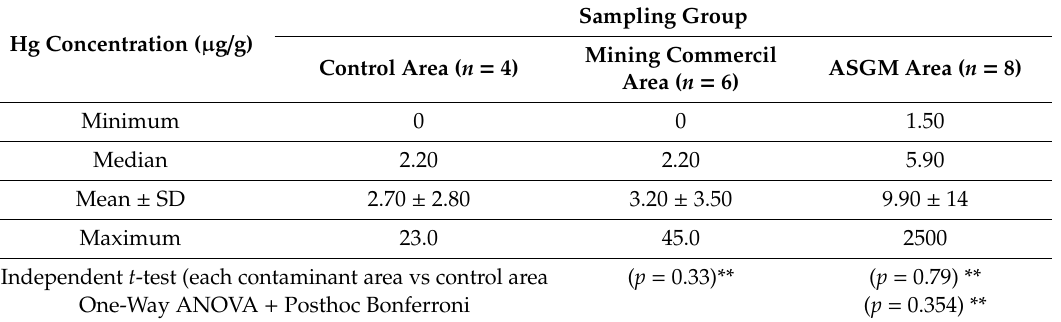
Table 2. Distribution of forage plants sample based on the minimum, median, mean, standard deviation, and maximum Hg